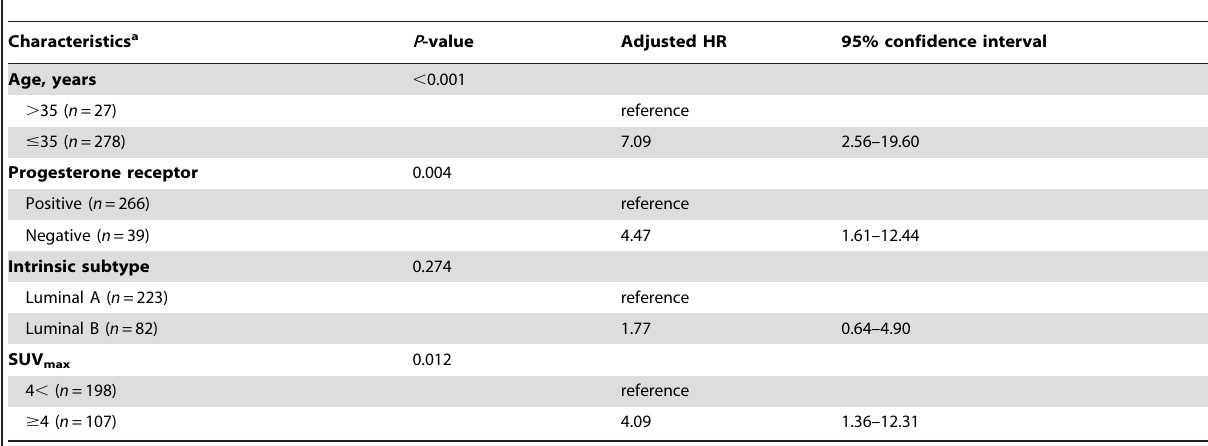
Table 2. Multivariate analysis using Cox regression hazard model for recurrence-free survival.